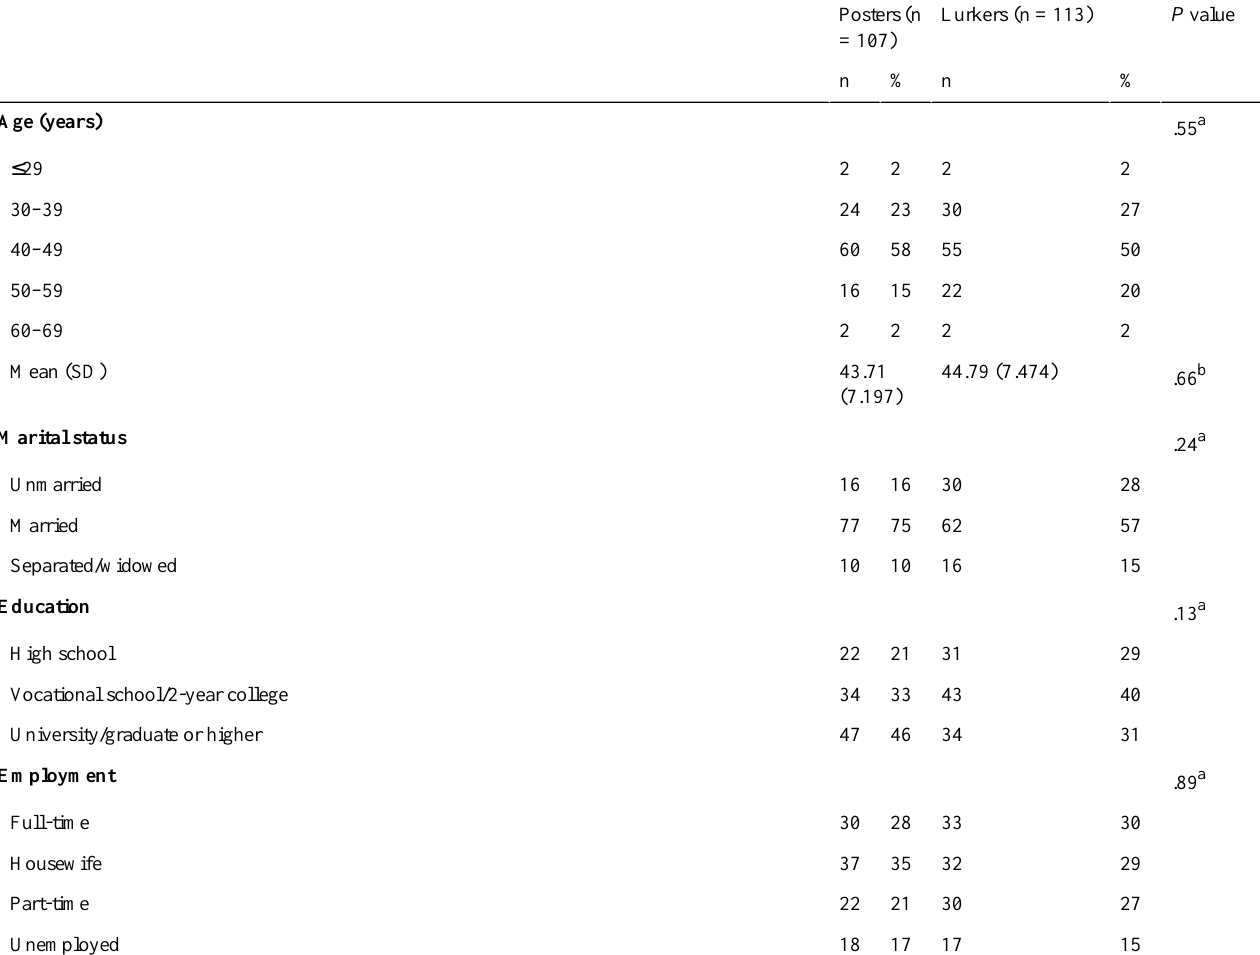
Table 1. Sociodemographic characteristics of posters and lurkers (n = 220) (excluding missing data)